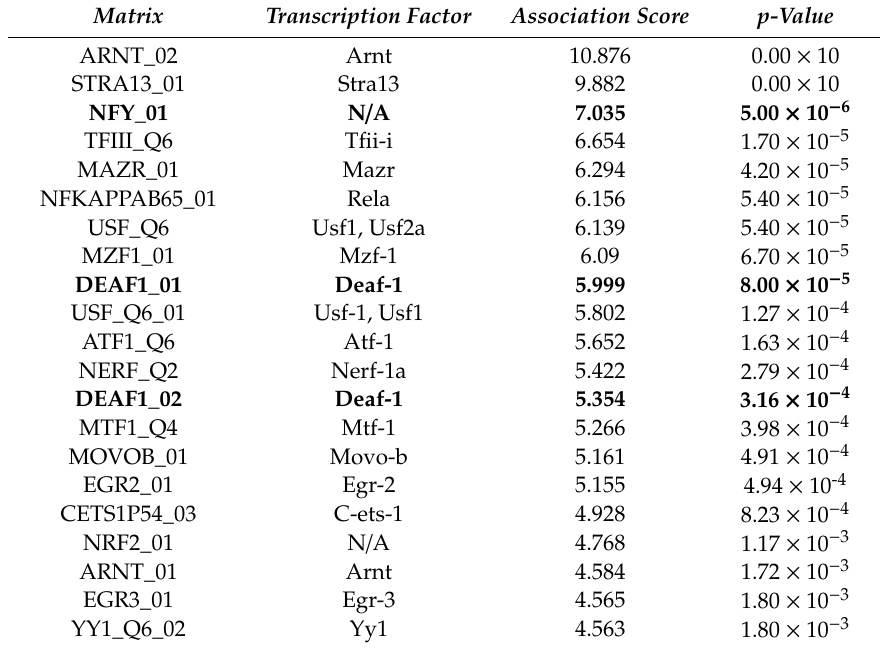
Table 1. Proximal analysis ( ± 400 bp) of genes a ff ected by ML114 in hPSCs. Matrix